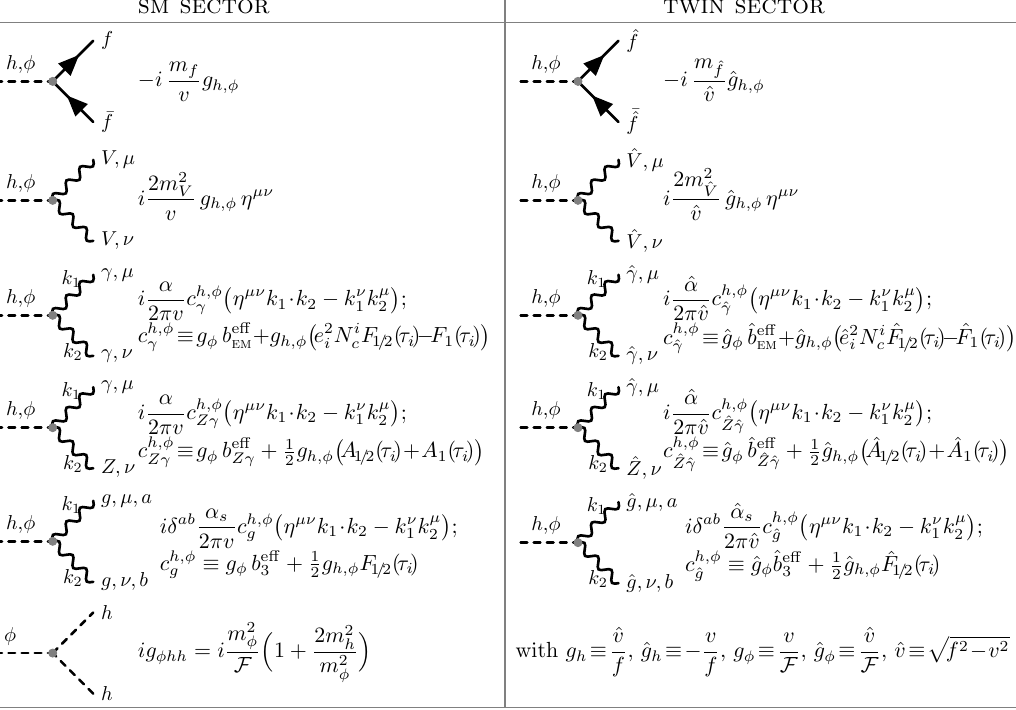
Table 1 . Feynman rules for the SM and twin sector particles coupling with the SM Higgs h ( x ) and the dilaton/radion (cid:30) ( x ) in the low energy e(cid:11)ective theory of a dilaton portal composite twin Higgs model. In our notation the e(cid:11)ective b e(cid:11) b < b > are the coe(cid:14)cients of the gauge coupling i (cid:17) i (cid:0) i beta functions de(cid:12)ned as, (cid:12) i ( g i ) = b e(cid:11) g 3 = (16 (cid:25) 2 ), where i = 3 ; 2 ; 1 corresponds to gauge couplings of i i SU(3) c ; SU(2) L , and U(1) Y , respectively, and are de(cid:12)ned in eq. (2.18). The triangle loop functions are given in this appendix. The hatted quantities represent the twin